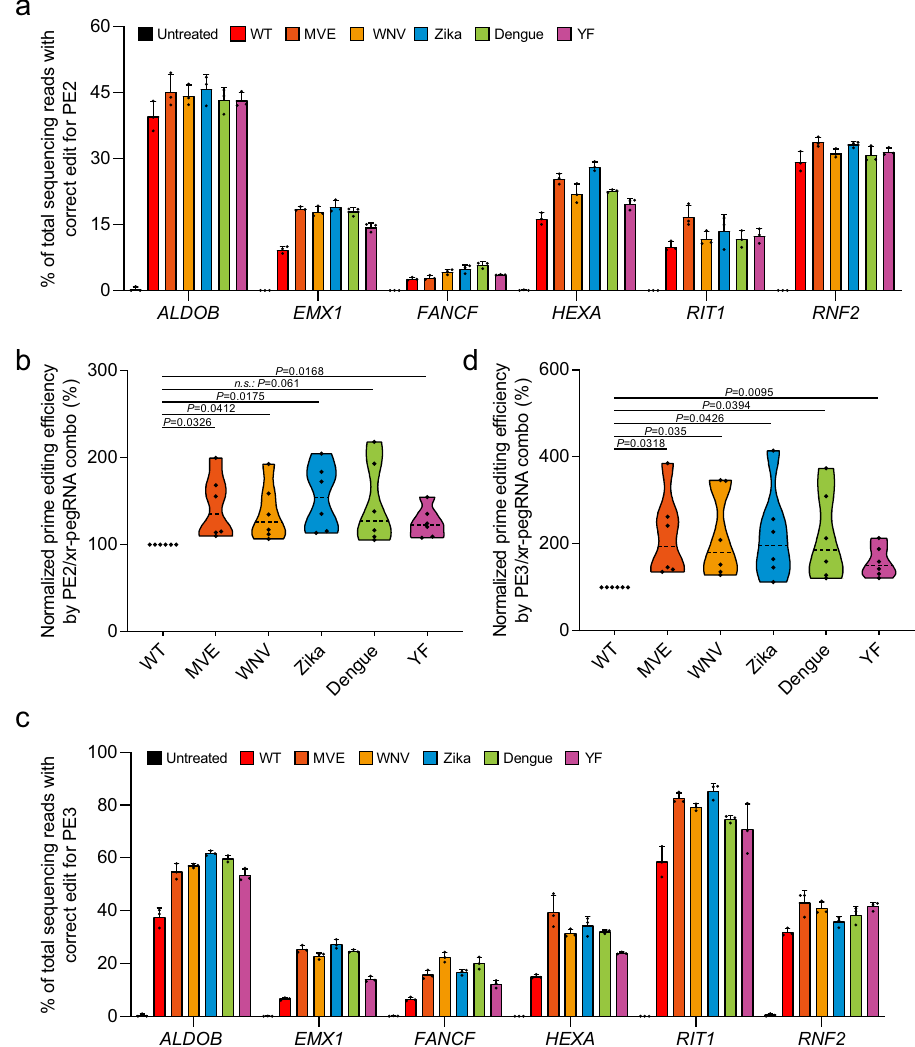
Fig. 2 The xr-pegRNA enhances prime editing of base conversions at various sites within genomic context. a HEK293T cells were co-transfected with plasmids for PE2 and WT pegRNAs or different xr-pegRNAs targeting indicated (6) genomic loci for base conversions. Following isolation of genomic DNA from transfected cells (sorted), correct editing rates at each site were determined by deep-sequencing (mean± SD, n = 3 biological replicates). Reads that only contain the intended edits were counted. b . Results in a is further analyzed by considering editing at all sites ( n = 6 sites) as a whole. The editing frequencies induced by PE2 with WT pegRNA were set as 100%. c . Experiments were carried out similar to ( a ), except that a PE3 strategy was used (mean ± SD, n = 3 biological replicates). d Results in c is further analyzed by considering editing at all sites ( n = 6 sites) as a whole. The editing frequencies induced by PE3 with WT pegRNA were set as 100%. In the violin plots shown in b and d , each point represents the averaged editing activity at the particular site. The thicker dotted line shows the medians of all data points, while the thinner dotted lines correspond to quartiles (1st and 3rd). Two-tailed one-sample Student ’ s t tests were performed. The P values are marked on the graphs (n.s. not signi fi cant). Source data are provided as a Source Data fi